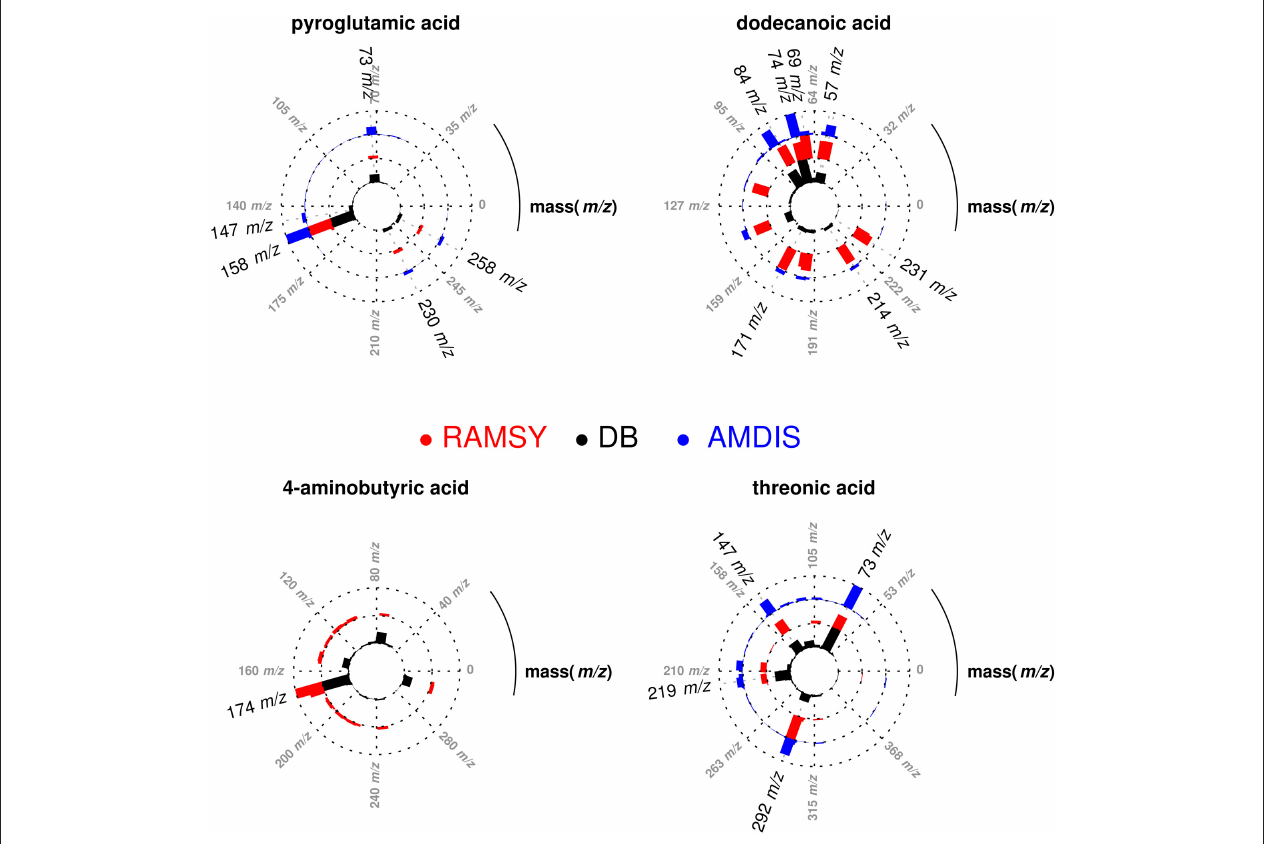
FIGURE 2 | Polar plot of “pure” MS spectra recovered from co-eluted GC-MS peaks between 7.45 and 7.60 min. Each lane corresponds to the mass spectrum obtained from AMDIS (blue), RAMSY (red) or database-DB (black). Pyroglutamic acid (AMDIS MF MF 810 and RAMSY MF 920) and threonic acid (AMDIS MF = = was found only by RAMSY ( MF =